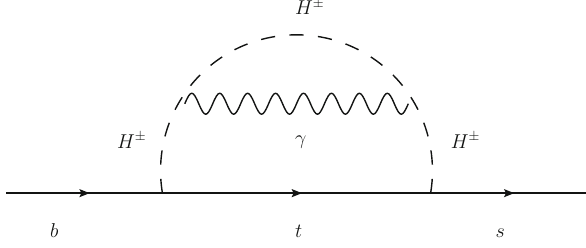
Fig. 3 The two loop diagram which dressing Fig. 1a with photon exchanges, where a real photon or gluon is attached in all possible